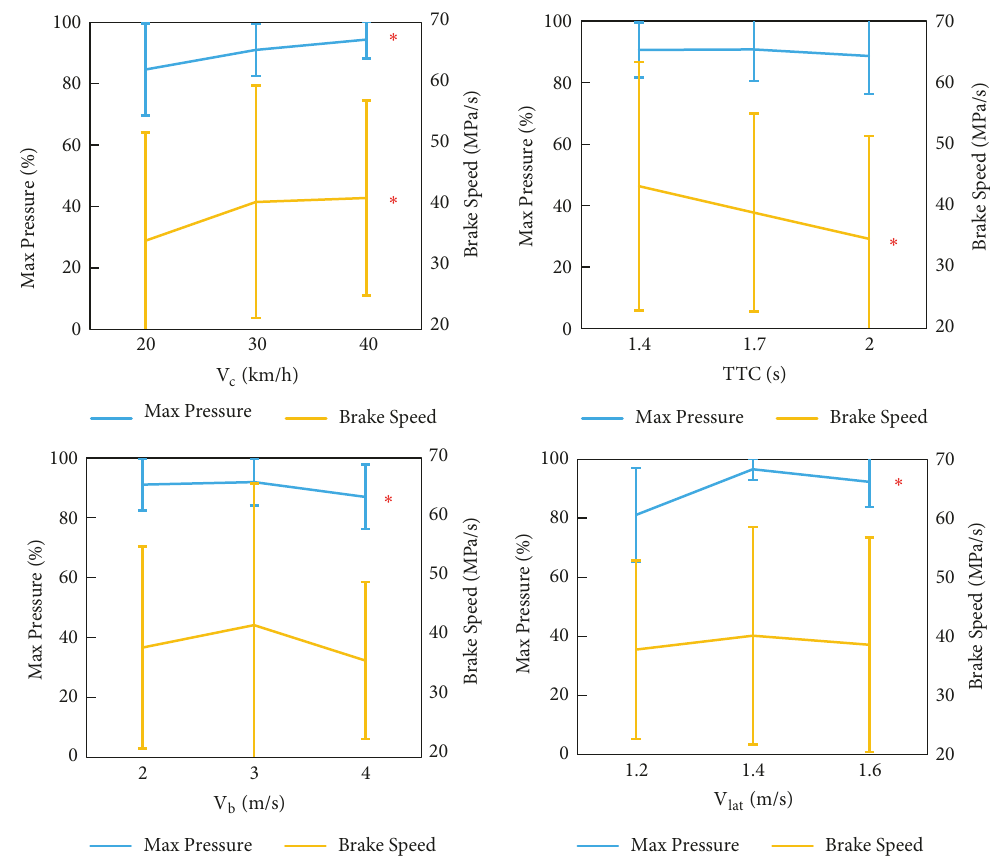
Figure 8: The average ( ± SD) of Max Pressure and Pedal Speed at three levels of the four parameters in SSR.